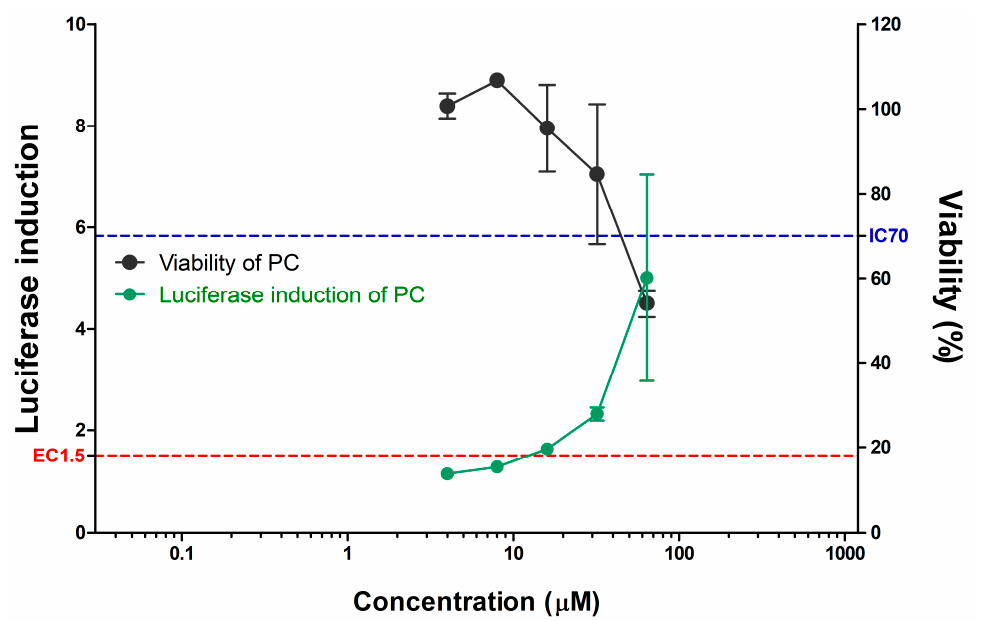
Figure 3. Luciferase activity (green line) and cell viability (black line) of positive control (cinnamic aldehyde, CASRN. 14371-10-9) in KeratinoSens ™ assay. Data are expressed as mean ± standard deviation values ( n = 6). Positive control (4–64 µ M) was tested in